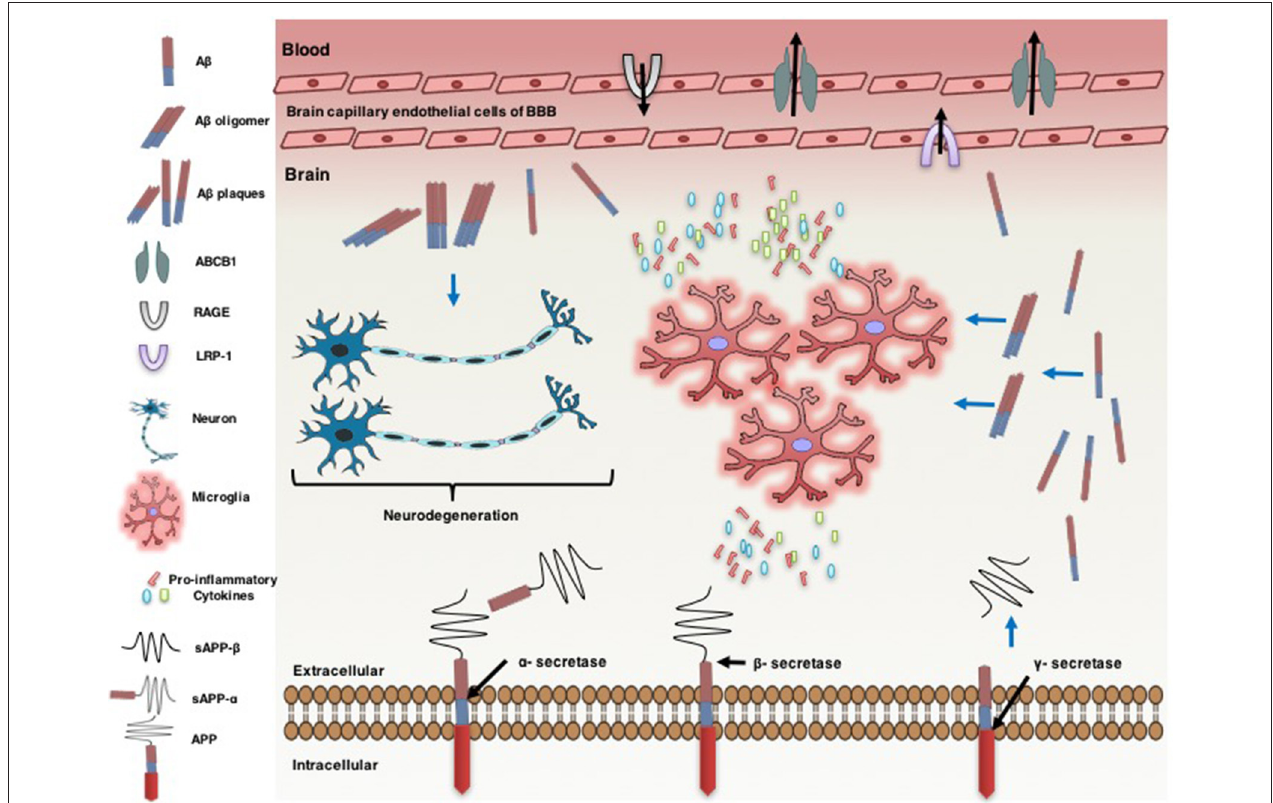
FIGURE 1 | Neuro-inflammatory cytokines modulate ATP-binding cassette B1 (ABCB1), affecting the pathogenesis of Alzheimer’s disease. Alzheimer’s disease is associated with an increase in the formation of amyloid beta (A β ) protein in the brain. Amyloid precursor protein (APP) generates A β through sequential proteolysis by beta ( β ) secretase and gamma ( γ ) secretase enzymes. Soluble APP-alpha (sAPP- α ) and soluble APP-beta (sAPP- β ) are produced through cleavage of APP by α -secretase and β -secretase, respectively. A β is transported across brain into the blood and vice versa by lipoprotein-related protein-1 (LRP-1) and the receptor for advanced glycation end products (RAGE), respectively. ABCB1 is also involved in uptake of A β from the brain into the circulatory system. However, the increase of A β plaque levels in the brain accelerates neuro-degenerations. The accumulation of A β leads to neuro-inflammation, characterized by activated microglia and the production of pro-inflammatory cytokines [e.g., interleukin-1 β (IL-1 β ), IL-6, and tumor necrosis factor- α (TNF- α )]. Pro-inflammatory cytokines overexpression down regulates ABCB1 expression in the endothelial cells of brain capillary at the blood brain barrier (BBB). Pro-inflammatory cytokines increase the expression of APP. This effect is associated with a further increase in the accumulation of A β in the